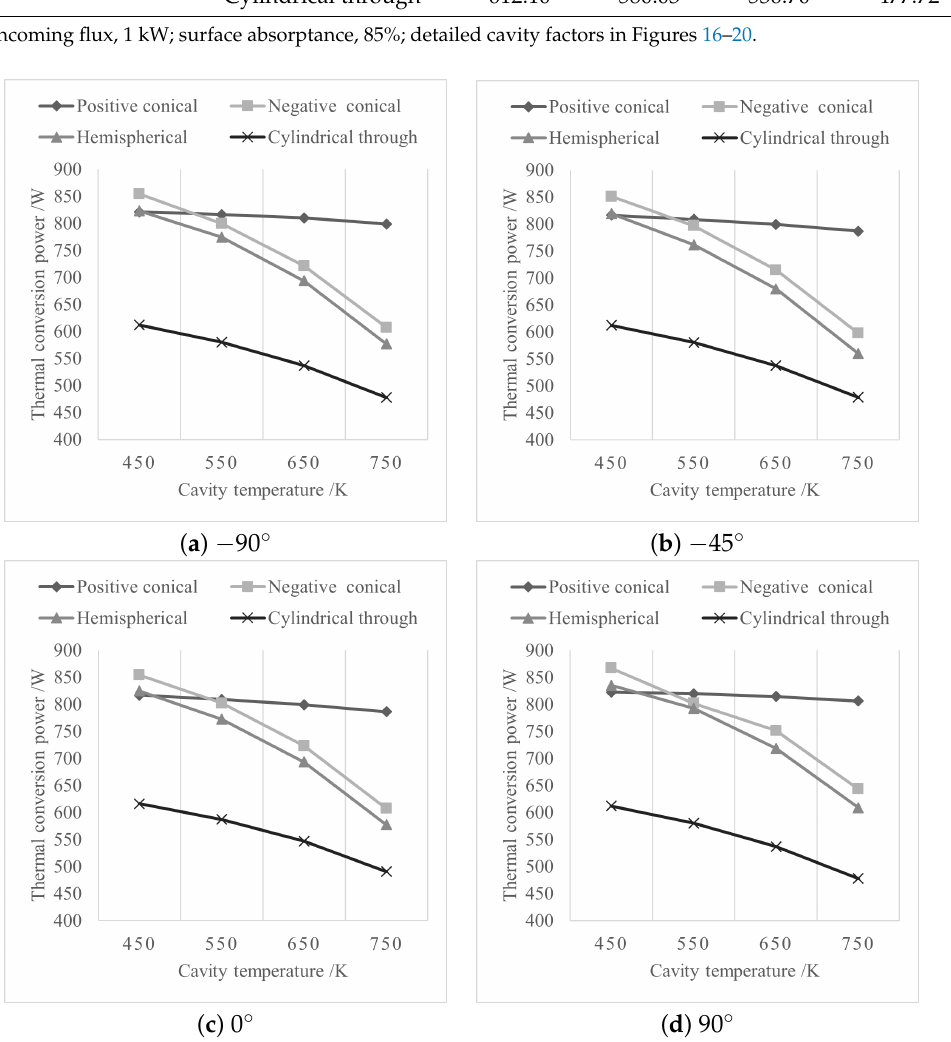
Figure 21. Thermal conversion at different inclinations. Identical incoming flux 1 kW, concentrated by Fresnel lens; temperature at 300 K; ambient